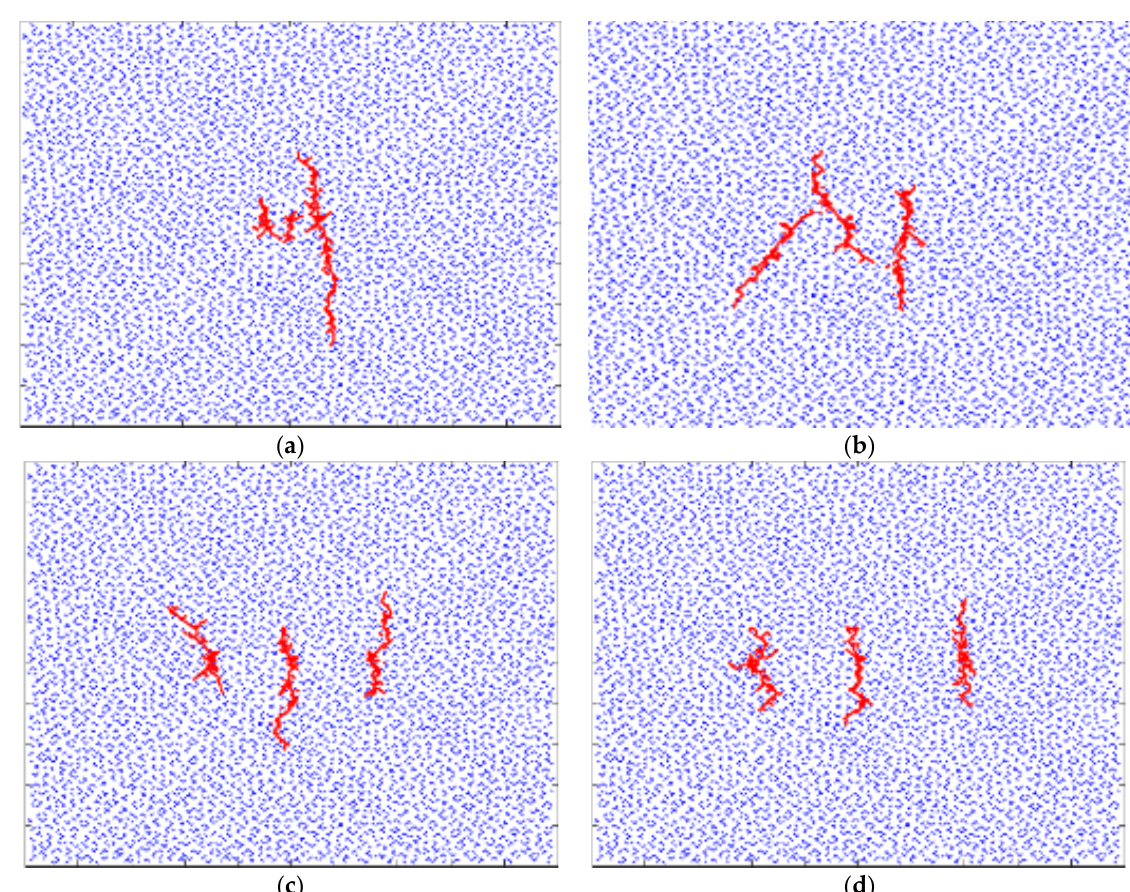
Figure 22. Fracture configuration distribution patterns during staged hydraulic fracture propagation in CBM reservoirs under various fracturing intervals. ( a ) 10 m, ( b ) 20 m, ( c ) 30 m, ( d ) 40 m.